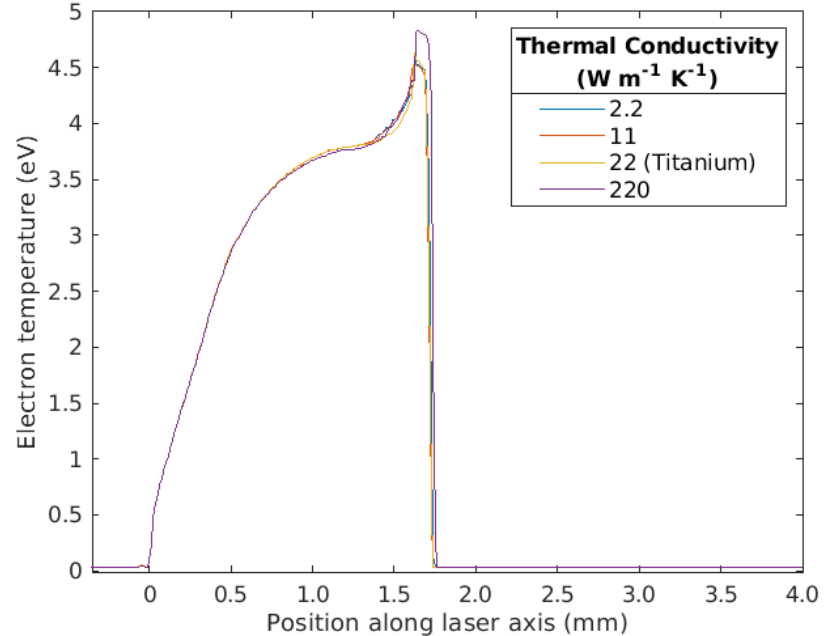
Figure 7. Comparison of the spatial distribution of the electron temperature of an ablated titanium plasma plume with varied thermal conductivity coefficient 25 ns after the laser pulse. The default thermal conductivity of titanium is 22 W m − 1 K − 1 . The laser fluence was 100.5 J cm − 2 and the laser focus was 100 µ